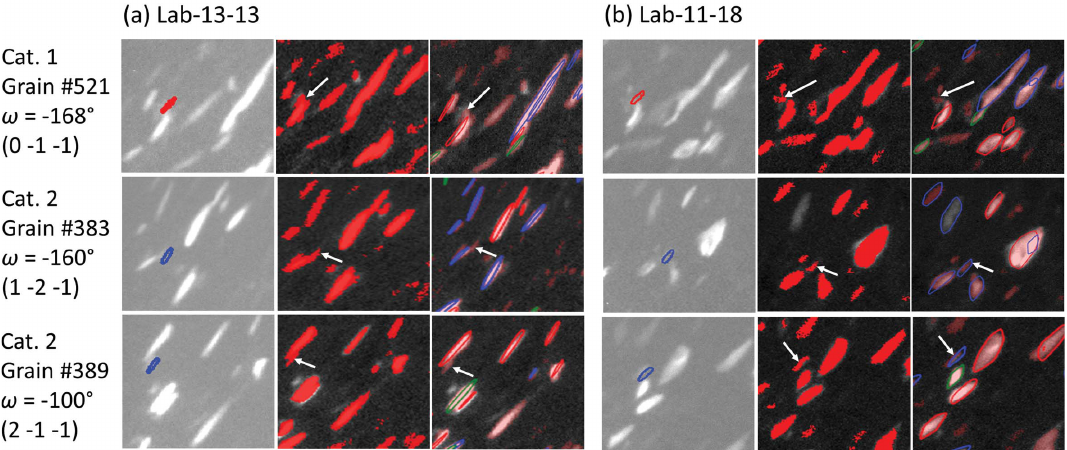
Figure 8 Overlay of the forward simulated spots (using the forward simulation tool; Fang et al. , 2020) for the false-negatively indexed grains of ( a ) Lab-13-13 and ( b ) Lab-11-18 onto the experimental image (left) together with the segmented image (middle) and the validation image (right) of the forward simulation from GrainMapper3D . Top-row images show spots for grain #521 (category 1), and middle and bottom rows show spots for grains #383 and #389 (category 2). The rotation angle ! and ( hkl ) for the spots are also given. Arrows indicate the spots that would be expected from these